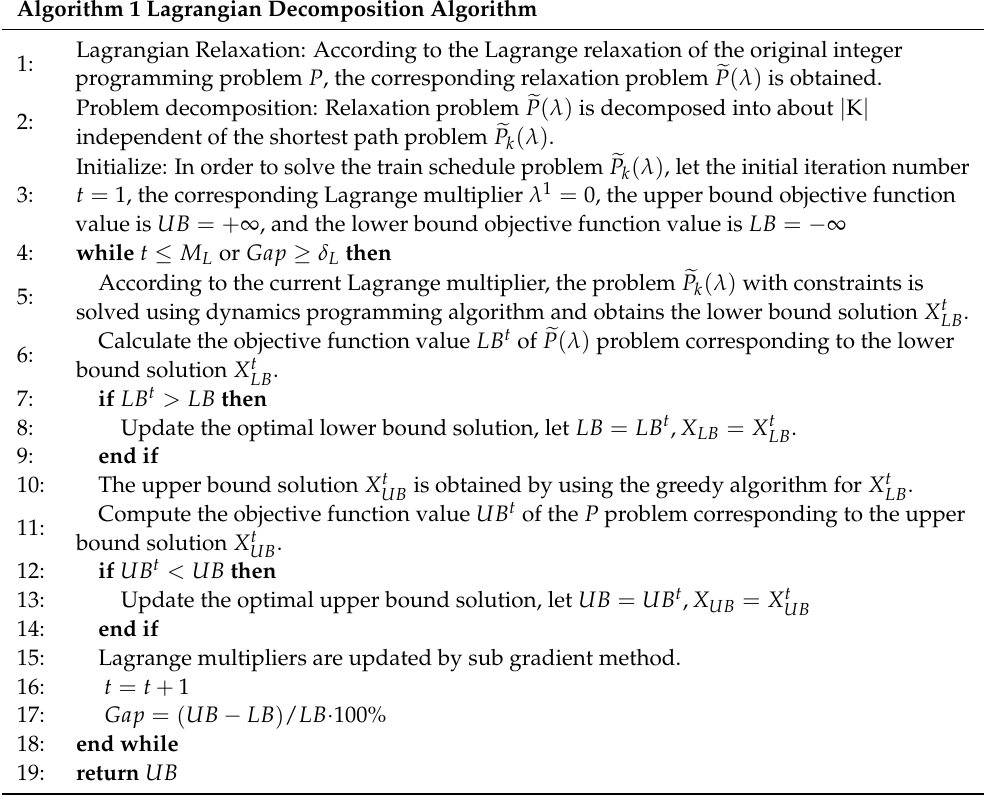
Algorithm 1 Lagrangian Decomposition